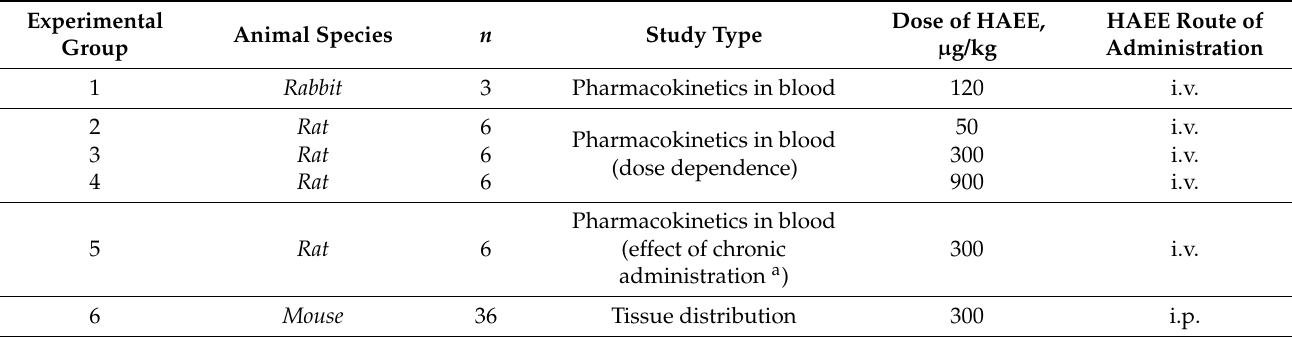
Table 1. Experimental